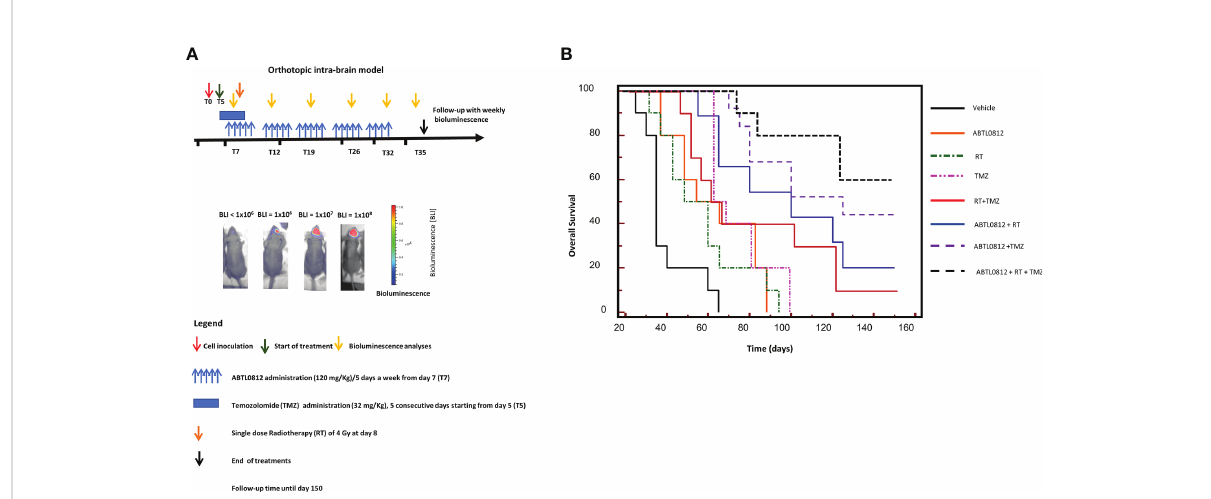
FIGURE 8 ABTL0182 potentiates the anticancer effect of the standard of care treatments radiotherapy and temozolomide in an orthotopic model of glioblastoma in mice (A) Diagram showing the experimental design of the treatment of glioblastoma orthotopic models using U87MG luciferase- tagged cells orthotopically inoculated into the brain of athymic nude mice and treated with ABTL0812 (120 mg/Kg), radiotherapy (4 Gy), temozolomide (32mg/kg) and combinatorial treatments. Tumors were monitored by bioluminescence detection which was performed every 7 days in order to determine Overall Survival (OS). (B) Overall survival of mice bearing U87MG-Luc cells orthotopic tumors. n=10 in each